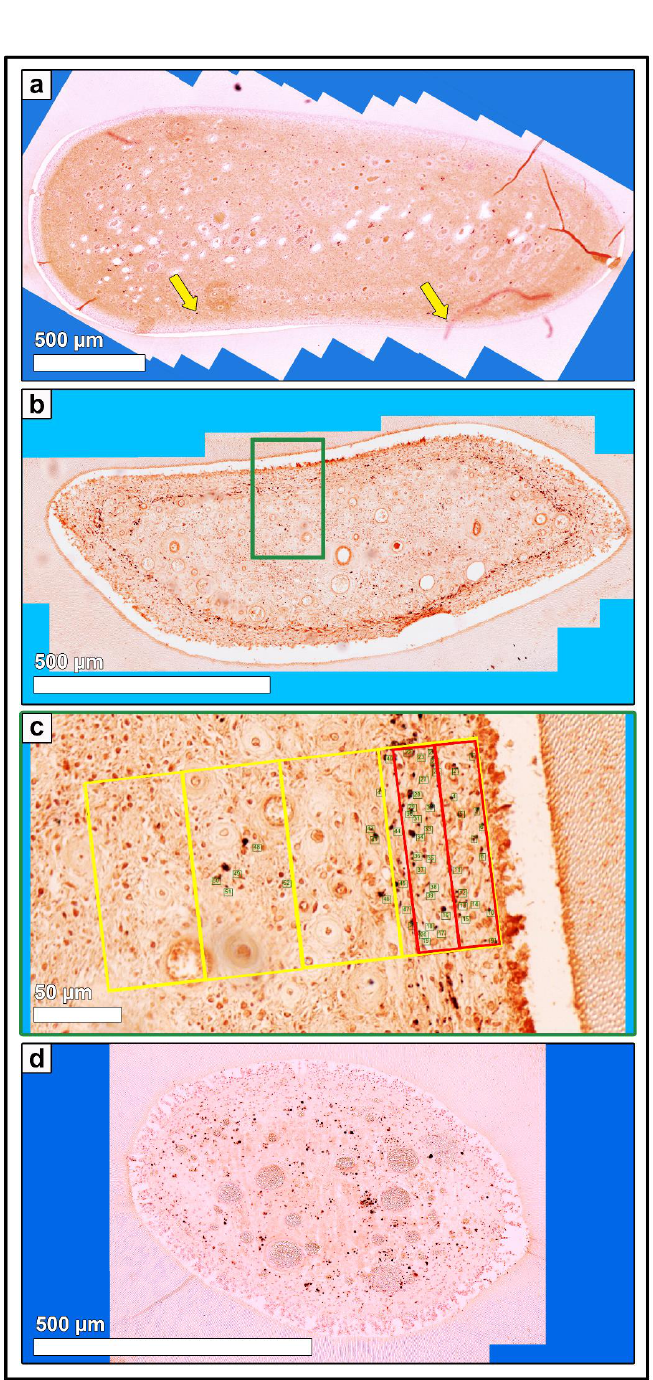
Figure 5. ( a ) Horizontal histological section ( so ) of a deciduous incisor (801) of a foal (210 days-old, AG 1), immunohistochemical stain (neurofilament protein, NF). 80–100 single high-resolution images were recorded using LAS X, XY Live Image Builder. Yellow arrows: indicate exemplarily isolated nerve fibers in the subodontoblastic area. ( b ) Horizontal histological section ( so ) of a permanent cheek tooth (208) of an adult horse (12 years-old, AG 2), immunohistochemical stain (NF). In the peripheral area of the dental pulp a subodontoblastic nerve fiber plexus is visible (accumulation of dark brown stainings). ( c ) Green rectangle, detailed high-resolution image (NF). Zones 1.a and 1.b (red rectangle) and zones 1 to 4 (yellow rectangle) were indicated. Green numbers mark the counted nerve fibers. ( d ) Horizontal histological section ( a ) of an incisor (301) of an older horse (19 years-old, AG 3), immunohistochemical stain (NF). In the peripheral area of the dental pulp a subodontoblastic nerve fiber plexus is visible (accumulation of dark brown